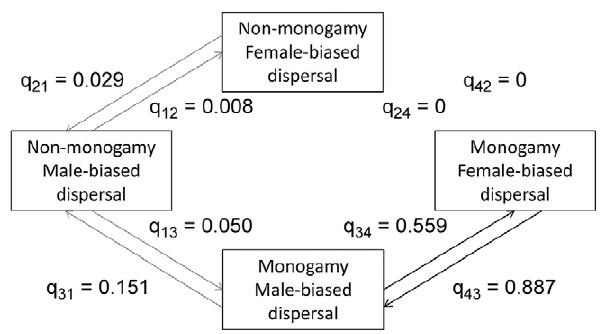
Figure 5. Path diagram showing evolutionary transition rates among four character states (mammalian dispersal distance dataset). Transitions from the ancestral state of non-monogamy and MBD to the derived state of monogamy and FBD for mammals using a dataset that quantifies sex-biased dispersal based on dispersal distances are shown. Arrow thickness is proportional to the magnitude of the transition rate.